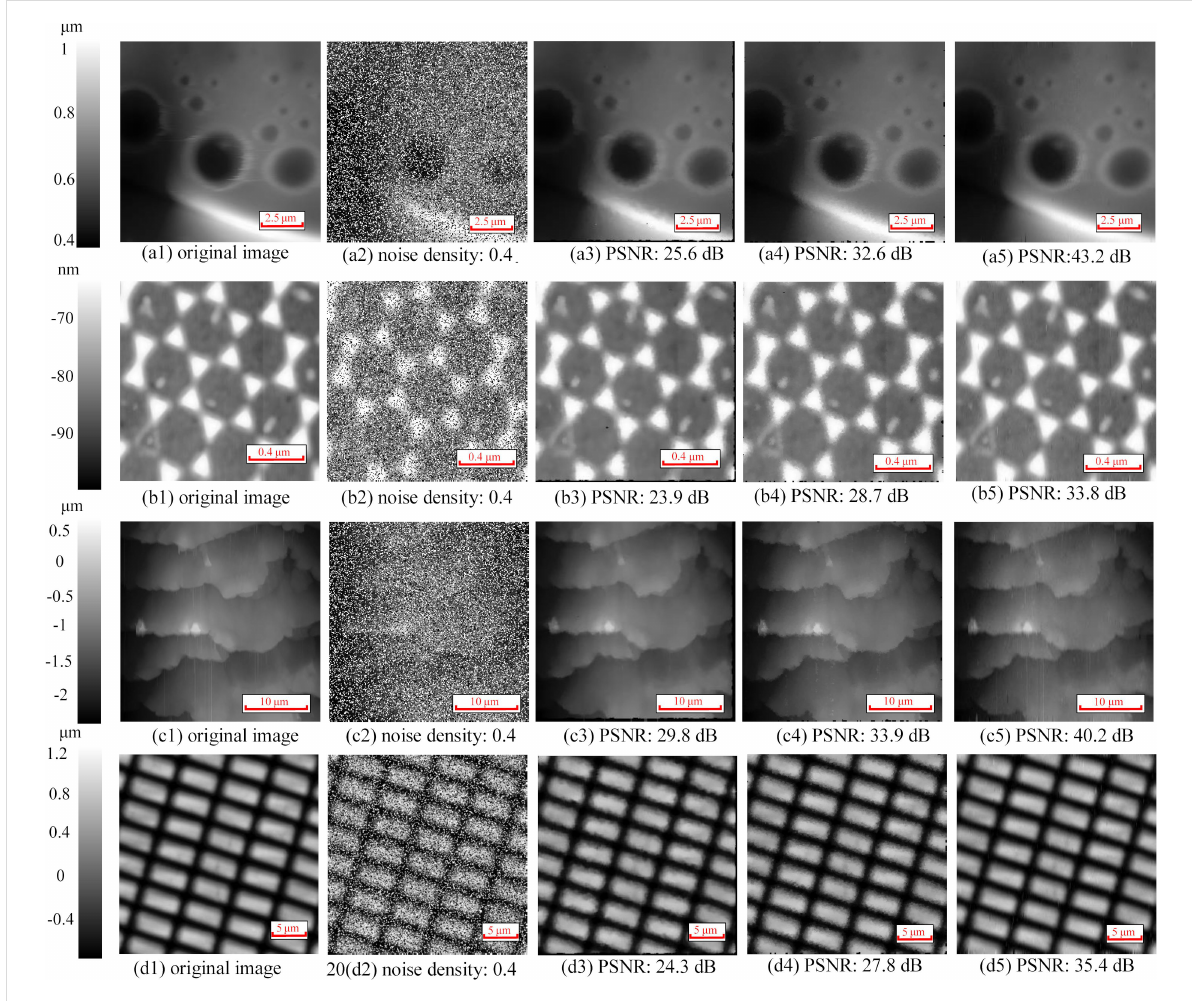
Figure 5: Denoised images. (a1–d1) Original images. (a2–d2) Images with added impulse noise with a density of 0.4. (a3–d3) Denoised images ob- tained by the median filter. (a4–d4) Denoised images obtained by the adaptive median filter. (a5–d5) Denoised images obtained by the self-compari- son-BCS denoising.